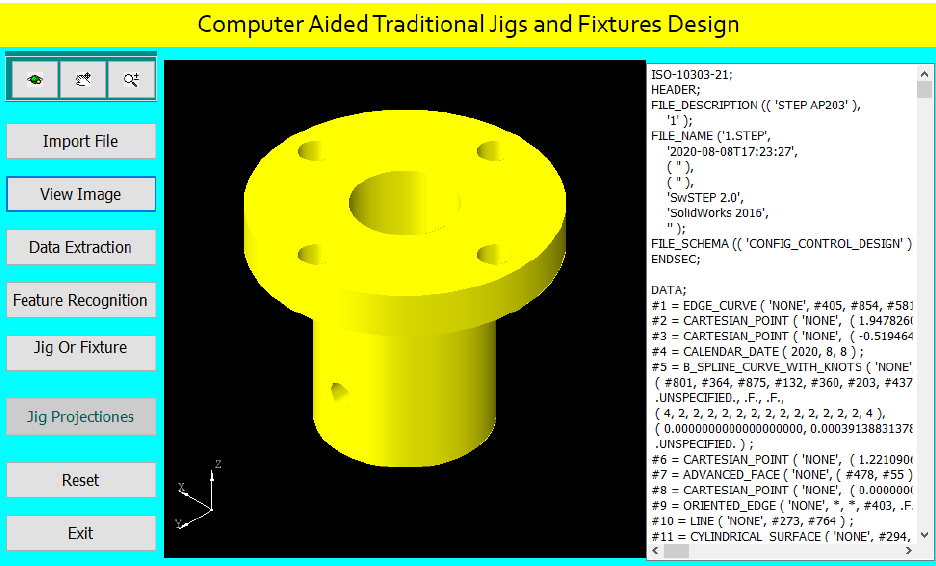
Figure 10. The system shows the part and the STEP AP-203 file.